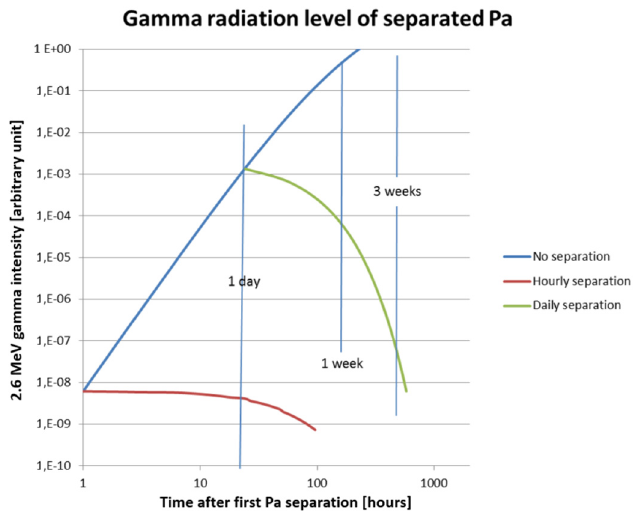
Fig. 6. In fl uence on the radiation level of a periodic extraction of the U and its descendants. An hourly extraction seems to be the most frequent feasible. A daily extraction is easier to implement but the radiation level of the diverted materials is then fi ve orders of magnitude